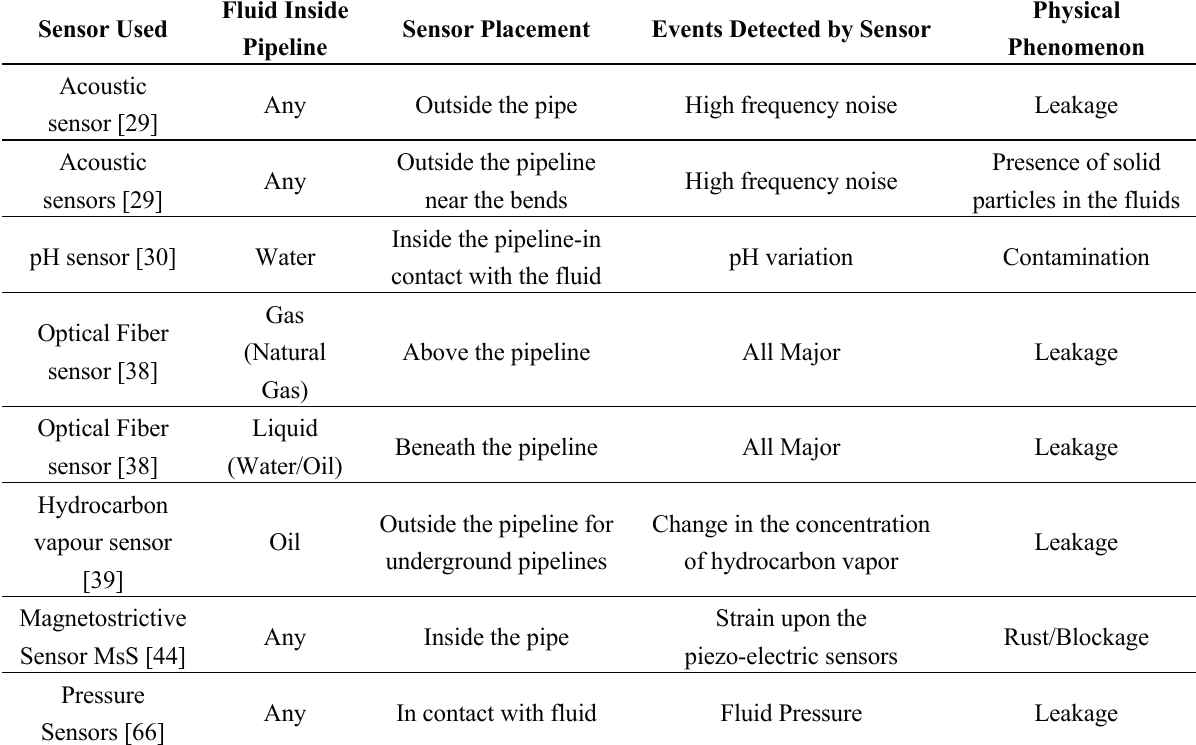
Table 5. Sensor devices used in industry for event